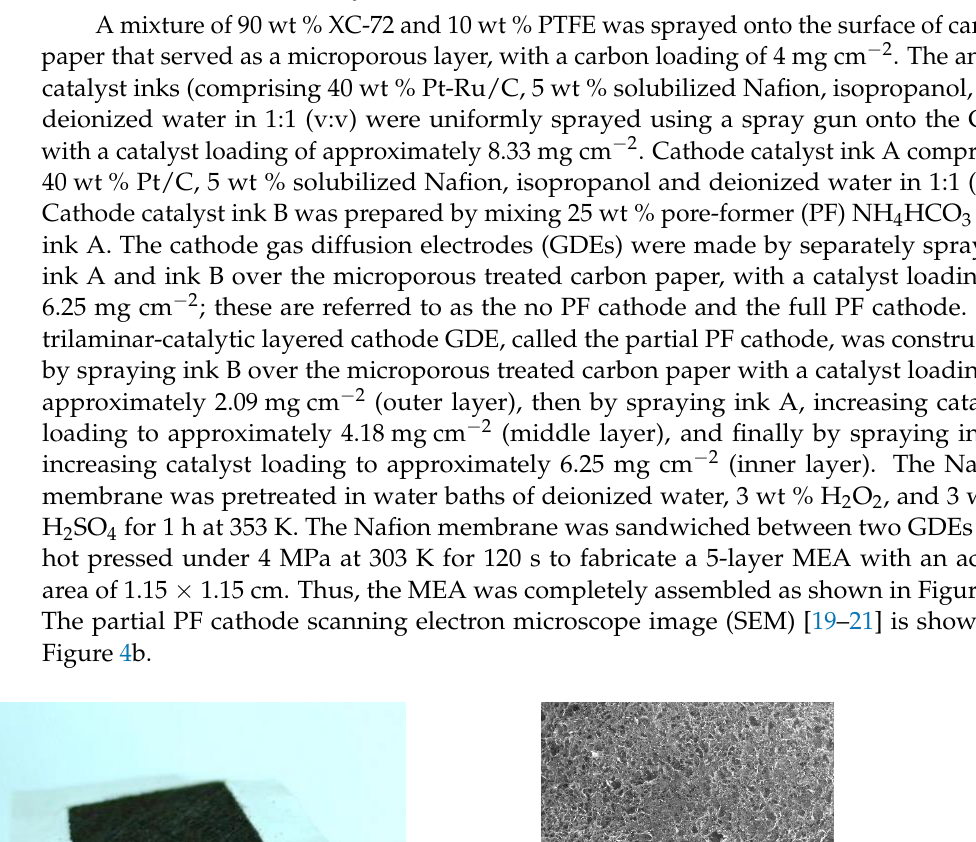
Figure 3. Comparison of oxygen mass fraction in the traditional catalyst layer and trilaminar-catalytic layer: ( a ) traditional catalyst layer; ( b ) trilaminar-catalytic layer.